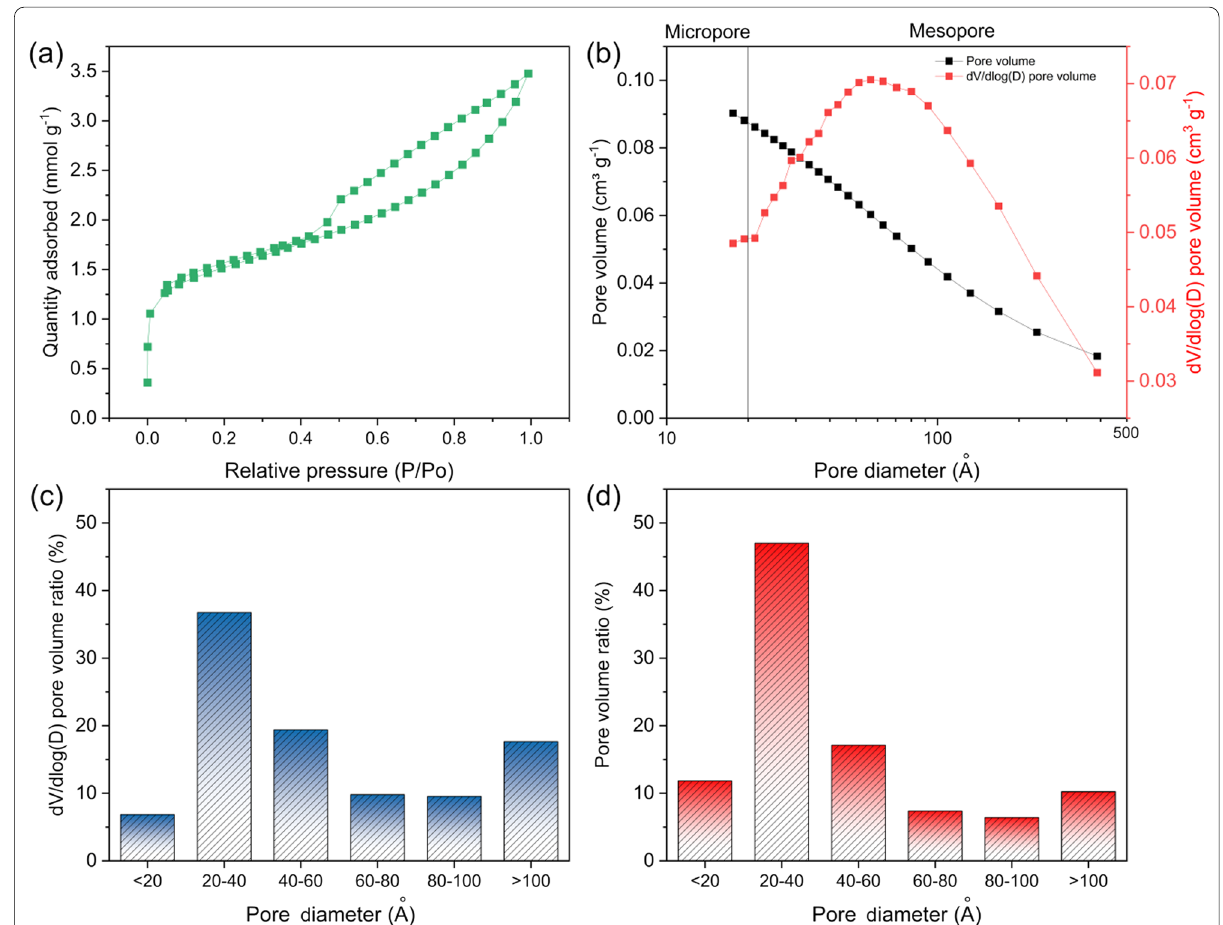
Fig. 1 The BET surface area and pore volume distribution for the DFW-BC. a is N 2 sorption and desorption curves. b is pore size distribution. c is dV/ dlog(D) pore volume ratio; and d is pore volume